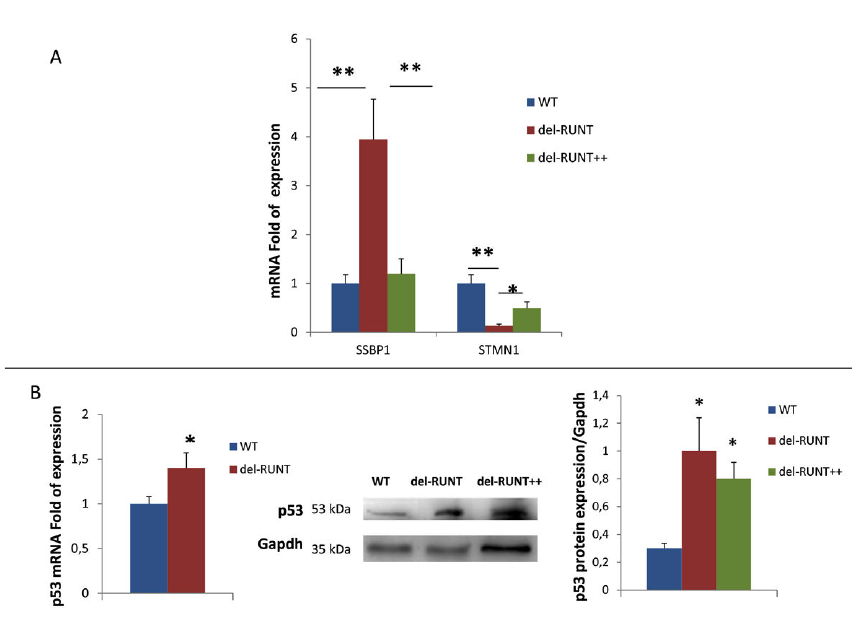
Figure 7. The mRNA expression of SSBP1 , a gene encoding for a protein involved in p53 stabilization, evaluated by Real Time PCR and normalized to the housekeeping genes B2M and GAPDH , was significantly higher in del-RUNT compared to WT cells. Conversely, the mRNA expression of STMN1 , involved in melanoma transformation, was reduced in del-RUNT cells. Expression of SSBP1 and STMN1 was restored in del-RUNT++ melanoma cells ( A ). P53 gene expression was increased in del-RUNT compared to WT cells ( B ). In addition, the WB analysis showed an increased expression of the p53 protein in del-RUNT cells and in del-RUNT++ cells compared to WT (A375 cells) ( B ) * p < 0.05; ** p <